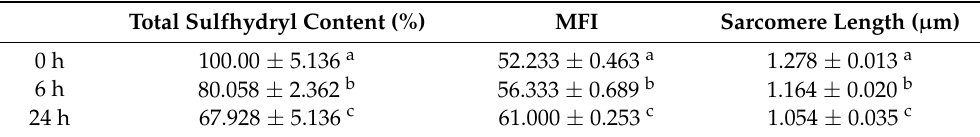
Table 2. Total sulfhydryl content, MFI (myofibril fragmentation index), and sarcomere length of Longissimus lumborum muscles during postmortem